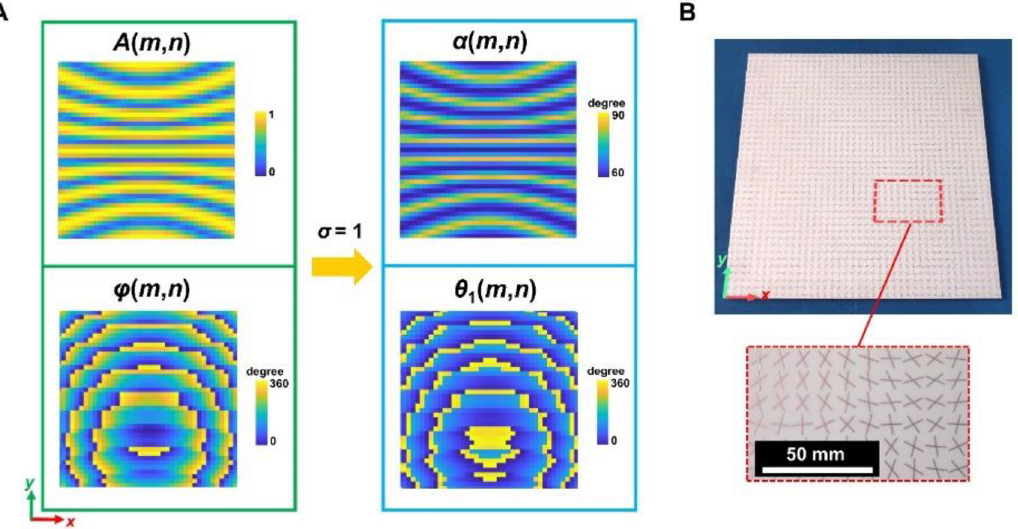
Figure 6: (A) The required amplitude, phase and geometric parameters α mn ( θ 1 mn ) distributions for the desired bi-foci metasurface. (B) The photograph of the fabricated sample. Inset shows the enlarged